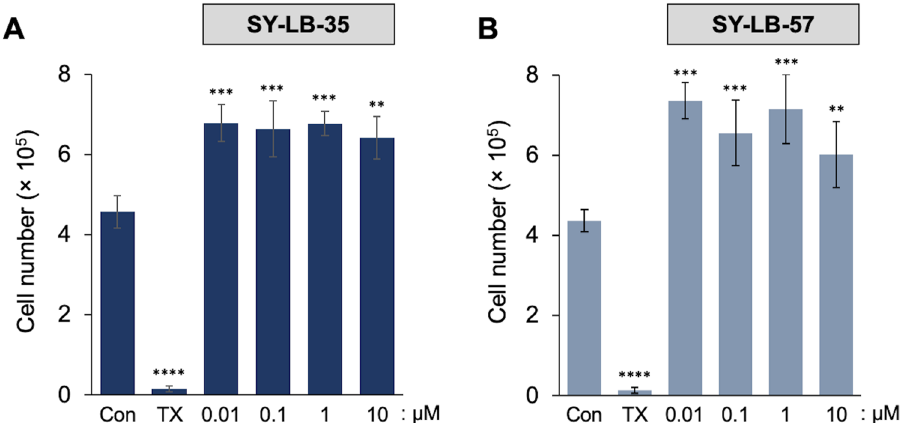
Figure 4. SY-LB-35 and SY-LB-57 increased cell concentration in C2C12 cells. Serum-starved C2C12 cells were treated with ( A ) SY-LB-35 and ( B ) SY-LB-57 (0.01–10 µM) for 24 h. Triton X-100 (TX) was used as negative control. C2C12 cells were collected after trypsinization, and the cell count was measured using Propidium iodide/Acridine orange. ( A ) Treatment with SY-LB-35 caused a significant increase in cell number compared with control, untreated cells (Con: 4.6 × 10 5 cells; 0.01 µM: 6.8 × 10 5 cells, 0.1 µM: 6.6 × 10 5 cells, 1 µM: 6.8 × 10 5 cells, *** p < 0.001; 10 µM: 6.4 × 10 5 cells, ** p < 0.01). ( B ) Treatment with SY-LB-57 caused a significant increase in cell number compared with control, untreated cells (Con: 4.4 × 10 5 cells; 0.01 µM: 7.4 × 10 5 cells, 0.1 µM: 6.5 × 10 5 cells, 1 µM: 7.2 × 10 5 cells, *** p < 0.001; 10 µM: 6.0 × 10 5 cells, ** p < 0.01). Data are expressed as mean ± SEM (n = 3) and each experiment was conducted in